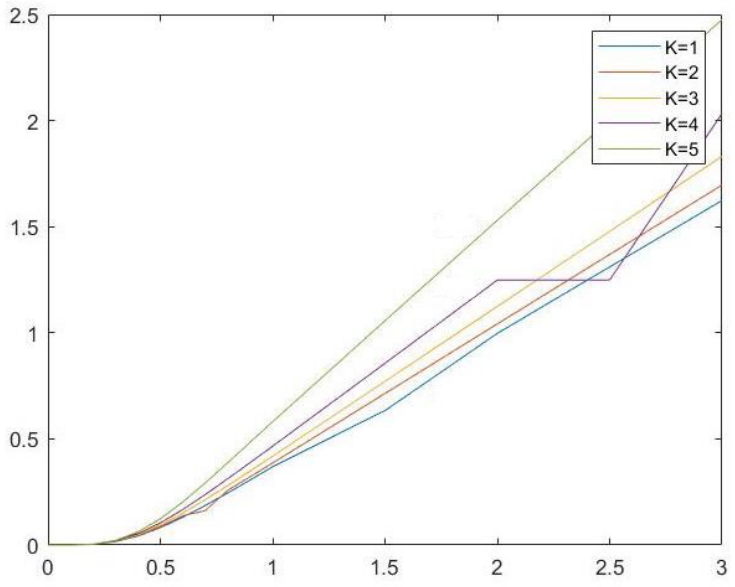
Figure 4. Mean number of replacements for systems K = 1,2,3,4,5.